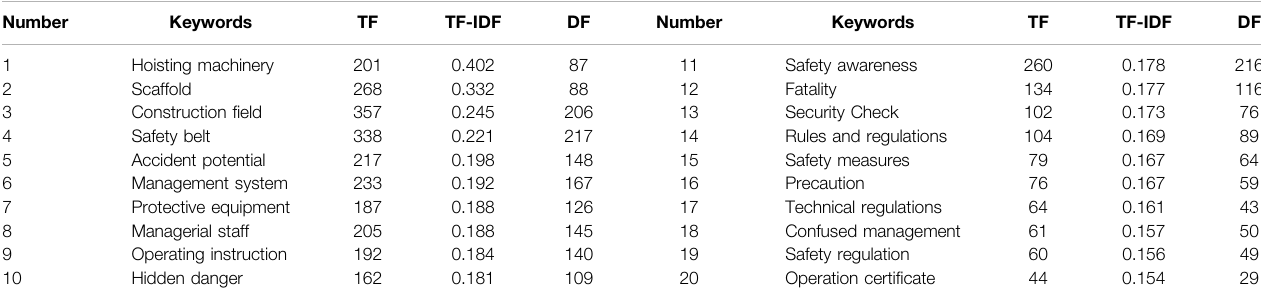
TABLE 2 | Analysis results of the characteristic indexes of the